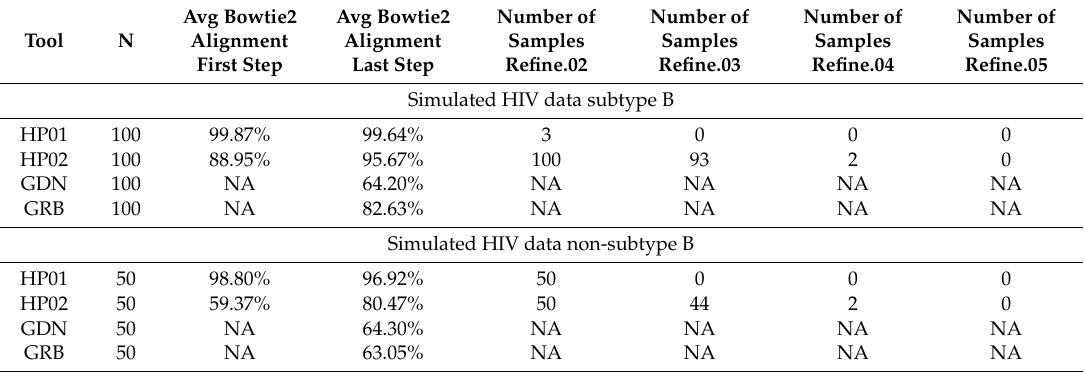
Table 2. Comparison of the de novo and reference-based assembly pipelines in HAPHPIPE for the simulated